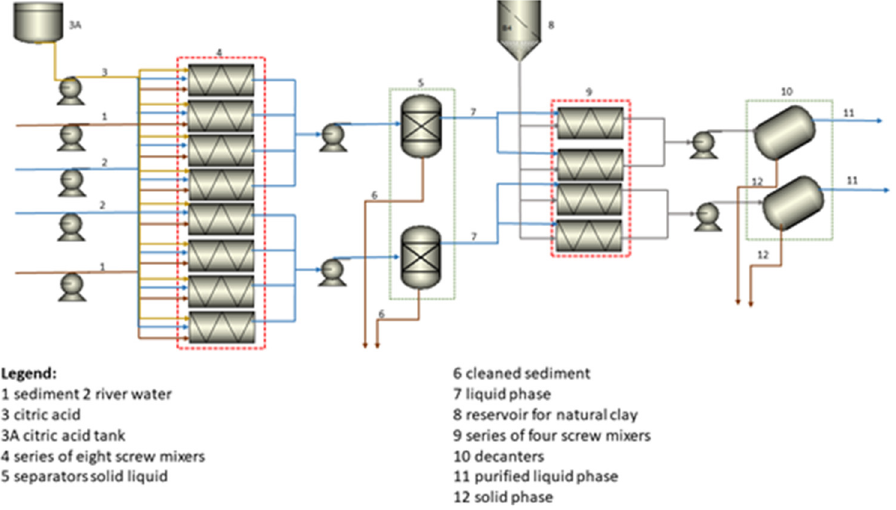
Figure 4. Process